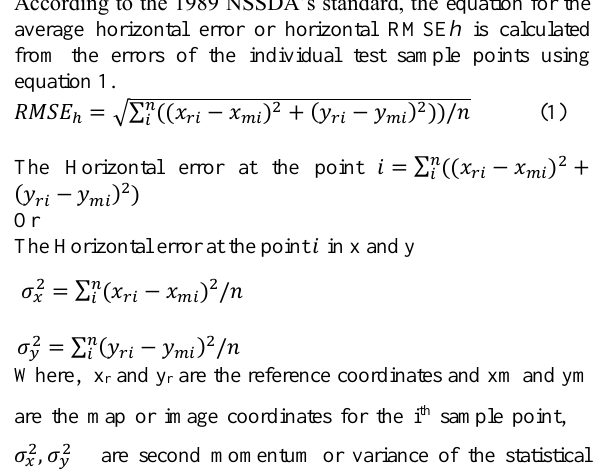
Table 1. GAMIT/GLOBK derived GPS coordinates of the checkpoints with their corresponding residuals errors and